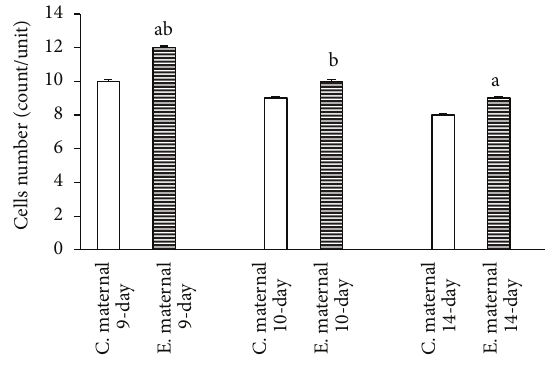
Figure 3: Reviewing the graph illustrating the time-dependent effect of oral morphine consumption on the development of the cells in the maternal portion of the placenta for three different periods of pregnancy (9-day, 10-day, and 14-day pregnant mothers), and a comparison between the experimental (E) groups and the control (C) groups reveals an increase in the number of cells in the maternal portion of the placenta in the experimental group, compared to that of the control groups ((a) 𝑃 value of < 0.01 and (b) 𝑃 value of < 0.05 indicating a significant difference).